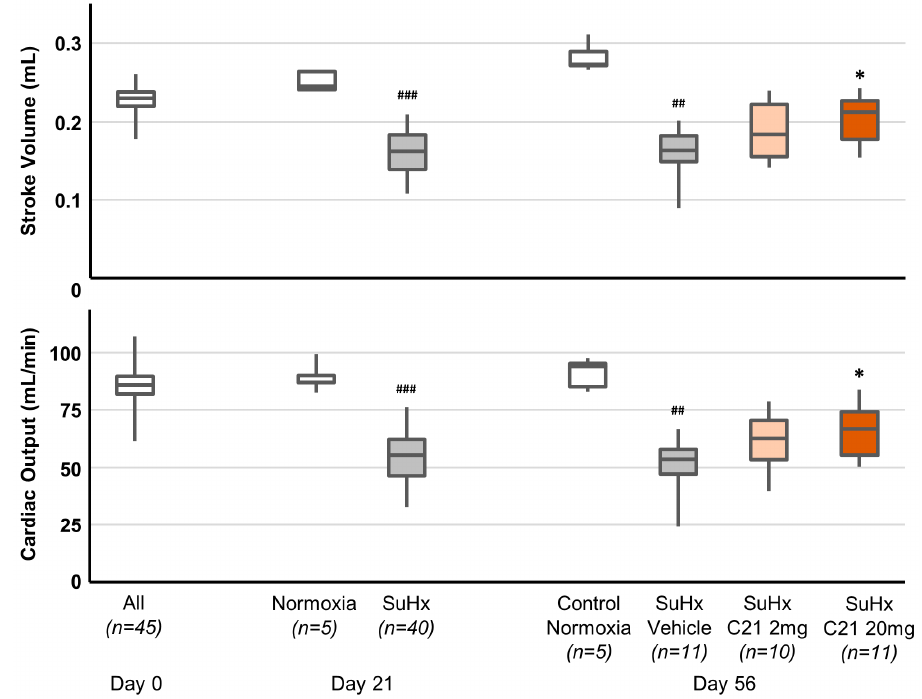
Figure 1. Hemodynamic assessments by echocardiography on day 0, day 21, and day 56. The box and whiskers represent the median, interquartile range, minimum and maximum values. ## p < 0.01 and ### p < 0.001 compared with normoxic animals (Mann–Whitney U-test). * p < 0.05 compared with SuHx Vehicle animals (Kruskal–Wallis test).